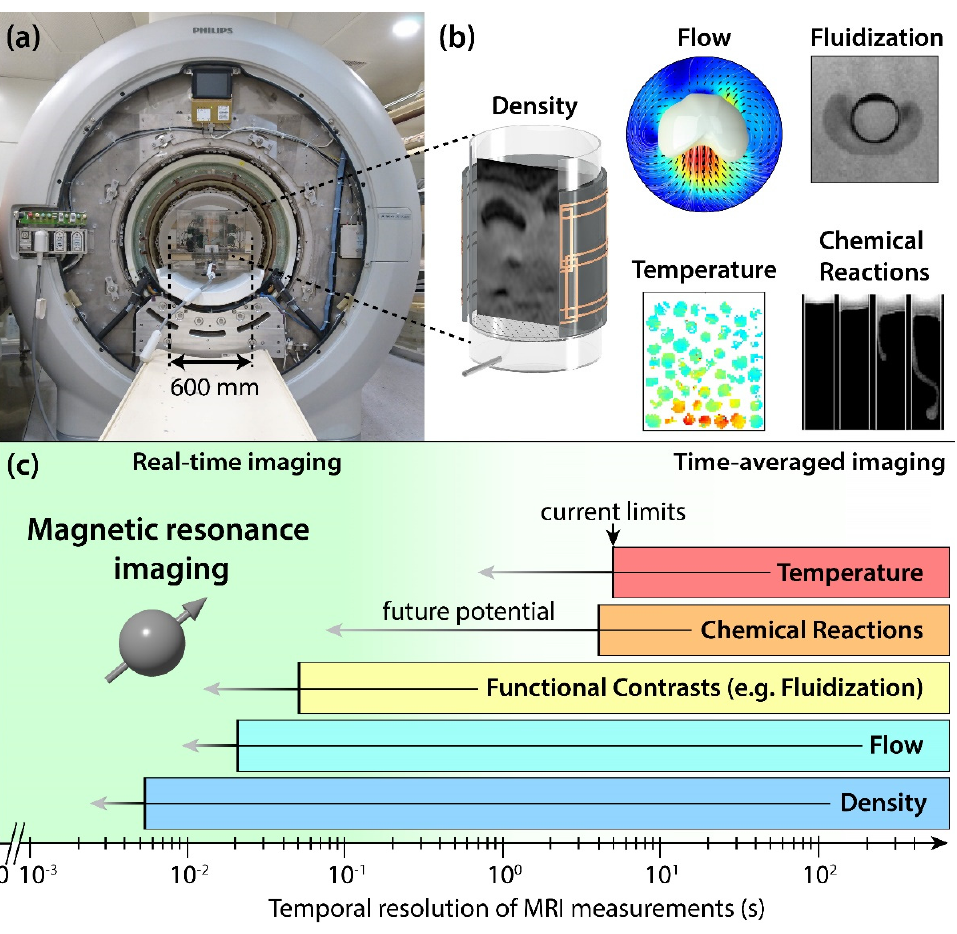
Figure 9. ( a ) Full body clinical 3T MRI scanner located at ETH Zurich. ( b ) MRI measurements of different sample properties. From left to right and top to bottom: Instantaneous snapshot of gas bubbles in a gas-solid bubbling fluidized bed [110], the flow of particles around a single gas bubble rising in a fluidized bed [110], cushion of locally fluidized particles observed below a single sphere sinking into an aerated particle packing [115] (reproduced with permission from Tsuji et al., Phys. Rev. Fluids 6, 064305, published by American Physical Society, 2006), temperature distribution of a particle packing heated from below by a stream of hot air [116], and an autocatalytic chemical reaction in which the reactants show a dark MRI contrast and the products a bright contrast [117] (reproduced with permission from Evans et al., JACS 128, 7309–7314, published by American Chemical Society, 2021). ( c ) Current limits of temporal resolution for different MRI measurements in process engineering systems and their expected gains using established image acceleration techniques (horizontal arrows).